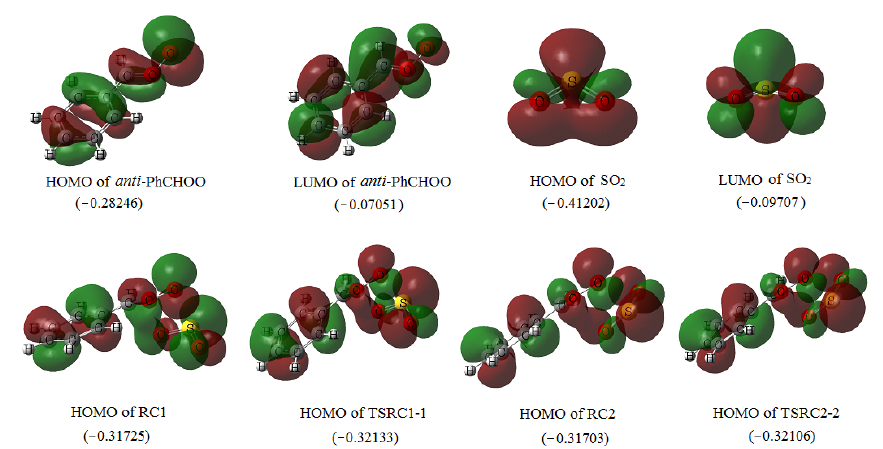
Figure 3. Highest occupied molecular orbital (HOMO) and lowest unoccupied molecular orbital (LUMO) orbital pictures of anti -PhCHOO and SO 2 , together with the HOMO of reactant complexes (RC)1, TSRC1-1, RC2 and TSRC2-2. The values in parentheses are the orbital energies (a.u.) calculated at the UBH&HLYP/6-311++G(d,p) level.